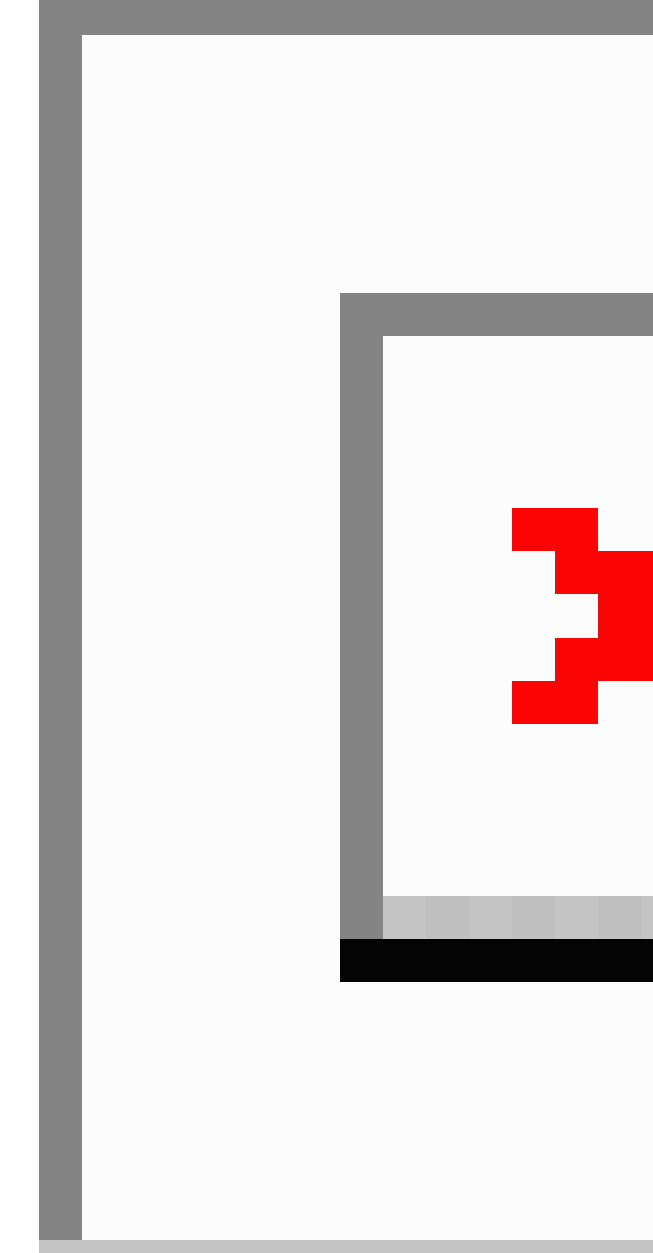
Figure 5. Drag-and-drop medication scheduling in